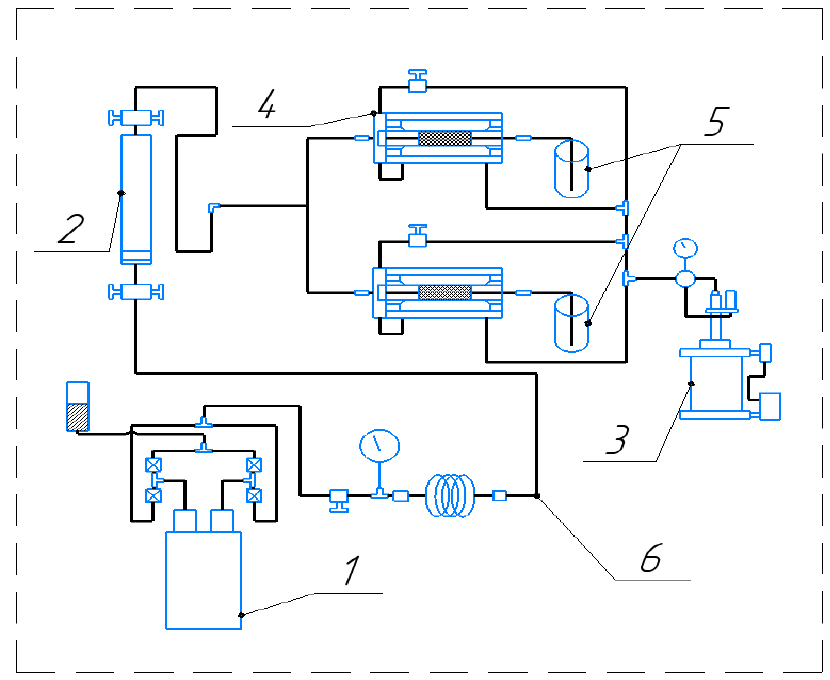
Figure 5. Schematic of the setup modeling a heterogeneous reservoir. 1, injection pump; 2, liquid container; 3, tightening system; 4, core holders; 5, measuring container; 6, alloy steel tubes.